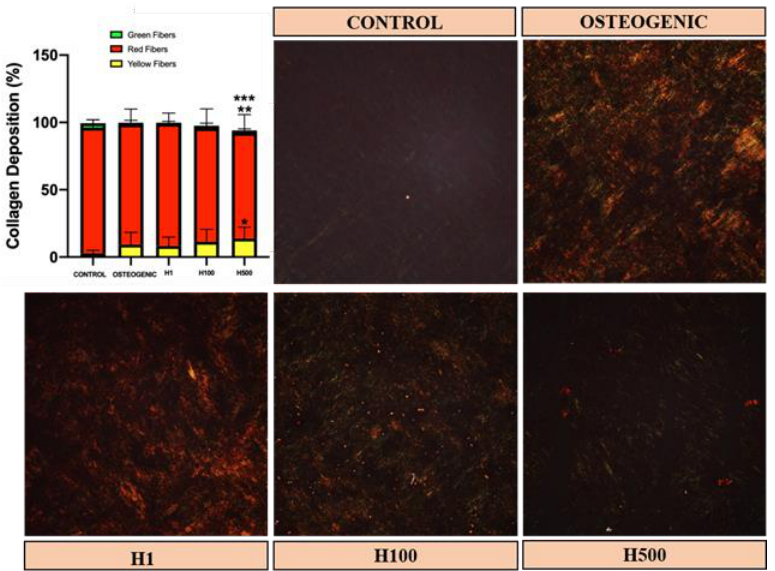
Figure 3. Picrosirius red (PSR) staining of MC3T3-E1 cell-produced collagenous matrices after culture for 21 days with and without hesperidin (H) in the medium (1, 100 or 500 µ M). Three independent experiments produced similar results and one representative polarized image of each condition is shown. The collagen matrices in H-treated samples maintained collagen at similar levels except for H500. H500 had reduced collagen accumulation and a significant decrease in red fibrils compared to other groups of treatment (red-color signal indicates presence of mature collagen) (** indicates difference compared to osteogenic medium alone at p < 0.05; *** indicates difference compared to osteogenic and other H groups at p < 0.05). Yellow fibrils (immature) increased in H500 (* indicates statistical difference compared to control). No green signal was detected in cultures (green depicts the least mature fibril, typical of early collagen deposits). All cells had similar viability as determined by CellTiter-Blue Cell Viability Assay ( n = 3, 10X magnification).